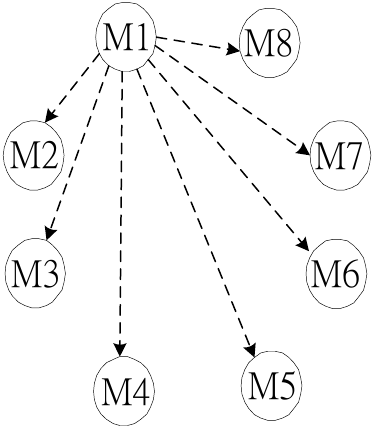
Figure 2. The formation topology of a Mesh-Ring backbone network.